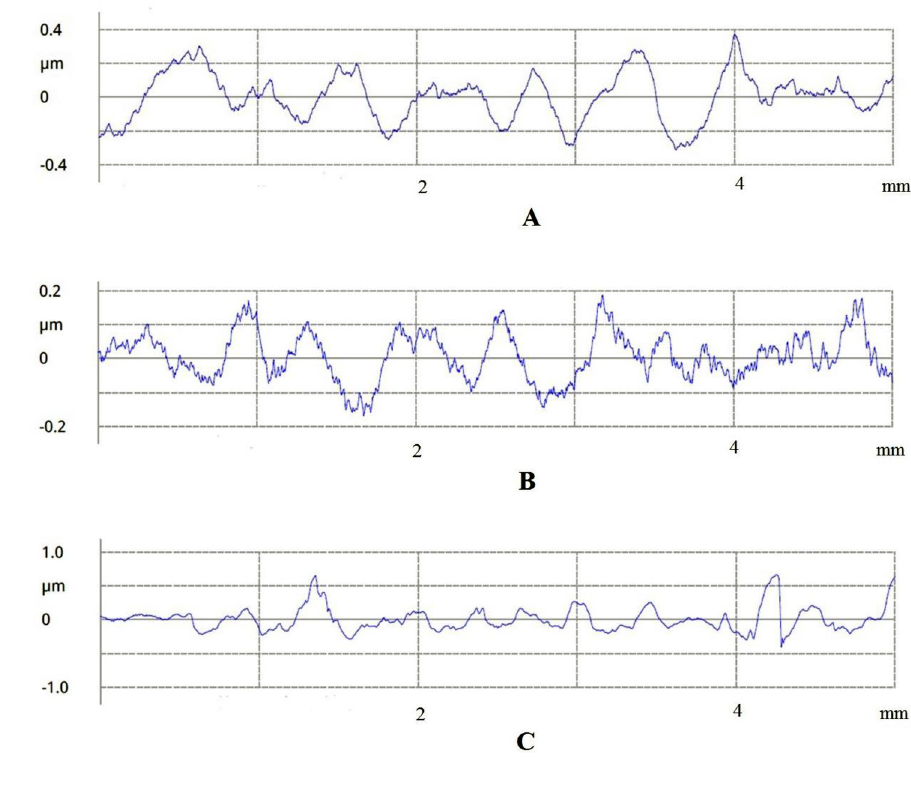
Fig. 20 Surface roughness profile of channels created in conditions of V = 0.6 mm/ min - U = 38 V, rotational speed